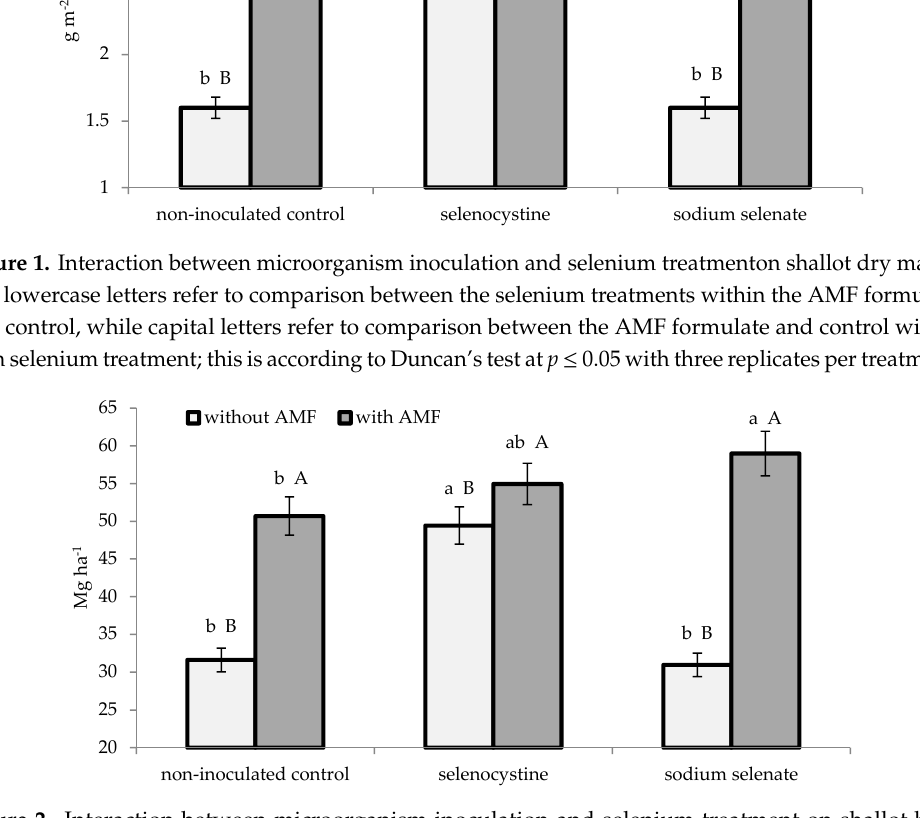
Figure 2. Interaction between microorganism inoculation and selenium treatment on shallot bulb yield. The lowercase letters refer to comparison between the selenium treatments within the AMF formulate and control, while capital lettersrefer to comparison between the AMF formulate and control within each selenium treatment; this is according to Duncan’s test at p ≤ 0.05 with three replicates per treatment.